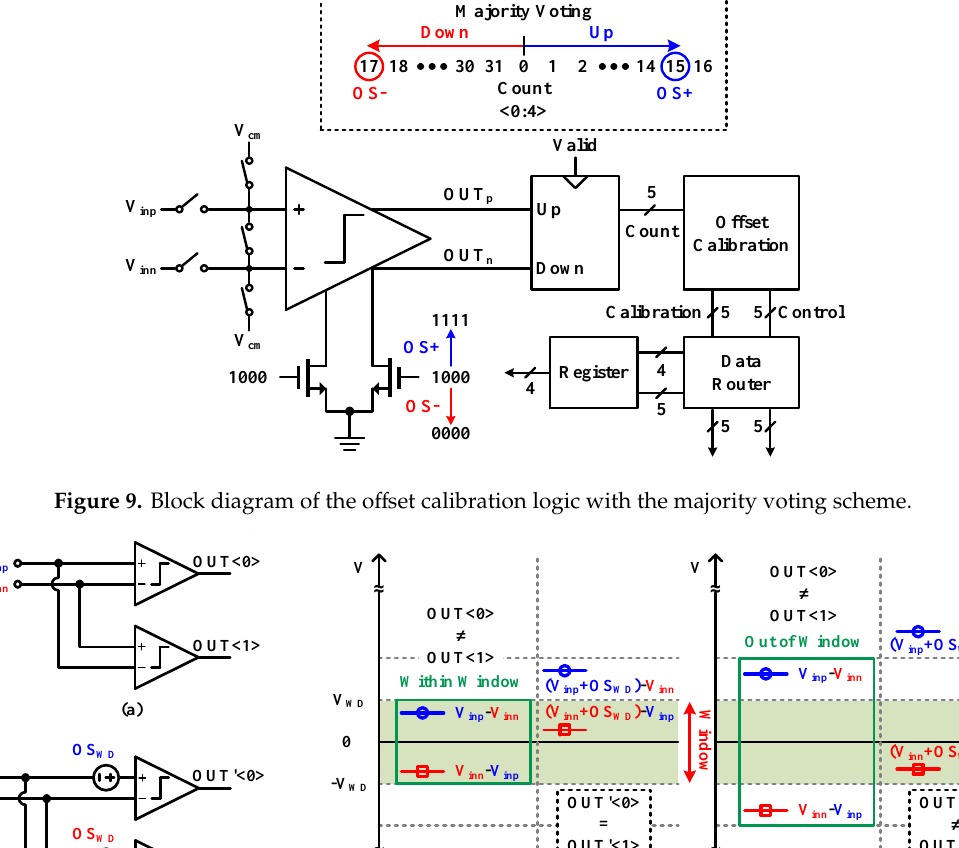
Figure 11. Relationship between window width, calibration accuracy and convergence time.